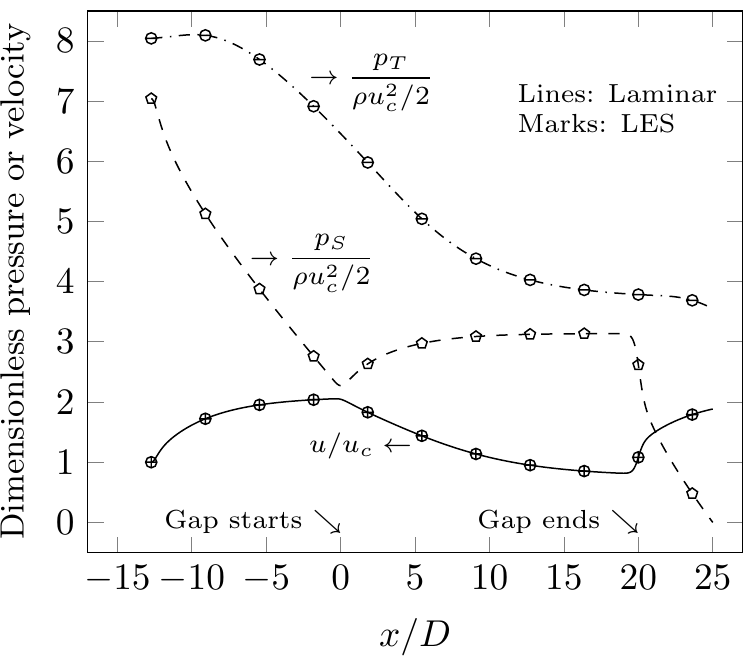
Figure 2. Comparison of the results from the laminar and LES models. For LES, the values correspond to the final steady state solution. Channel Re was 200. p T is total pressure, p S is static pressure, and u is velocity magnitude. For this figure, p T , p S , and u were taken from the center line along of the domain; hence, are local values but non-dimensionalized by using the channel